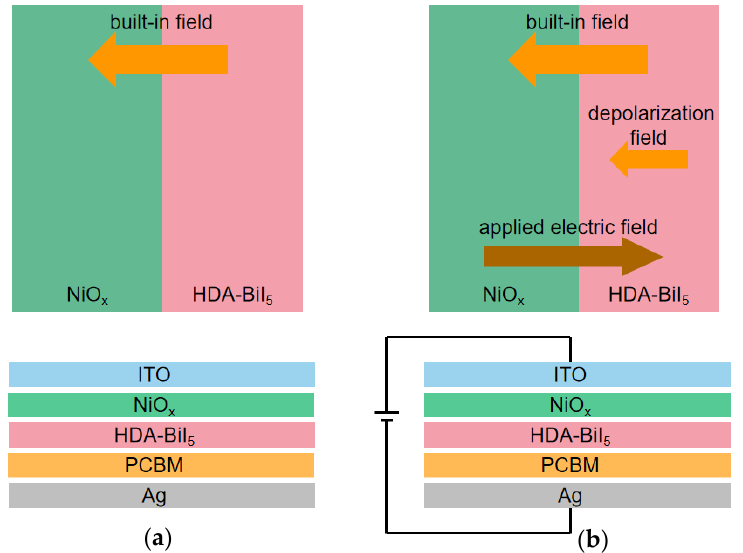
Figure 6. Schematic diagrams of (HDA-BiI 5 )-based ferroelectric solar cells under different conditions: ( a ) no polarization, and ( b ) polarization.